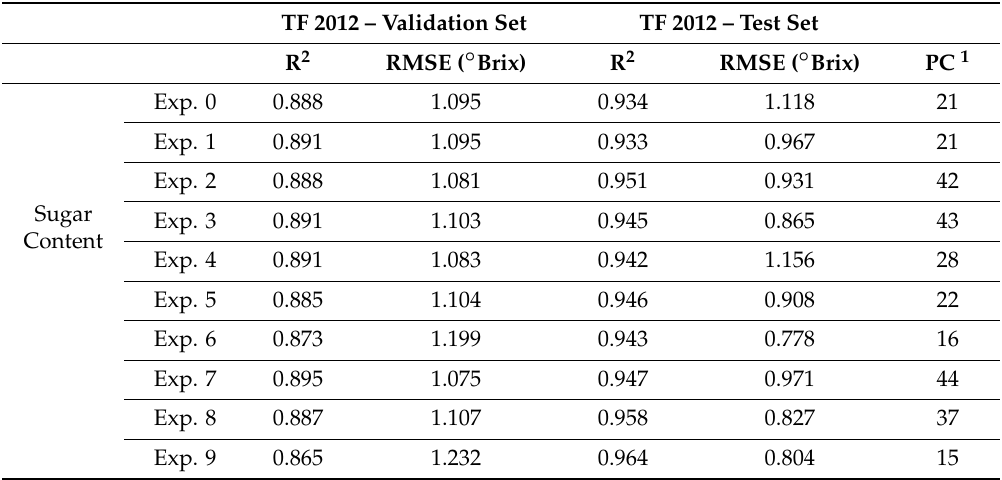
Table 7. Results obtained by the SVR model in 10 different experiments for the validation and test sets of samples from the TF 2012 vintage for sugar content